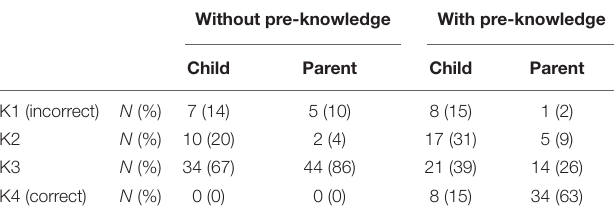
TABLE 4 | Parents’ and children’s solution accuracy of the inquiry activity. Without pre-knowledge With